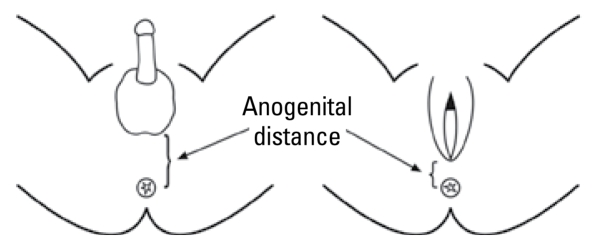
Schematic diagram of anatomical landmarks to measure AGD. (Reproduced from Salazar-Martinez et al. 2004, originally published in Environmental Health by Biomed Central).